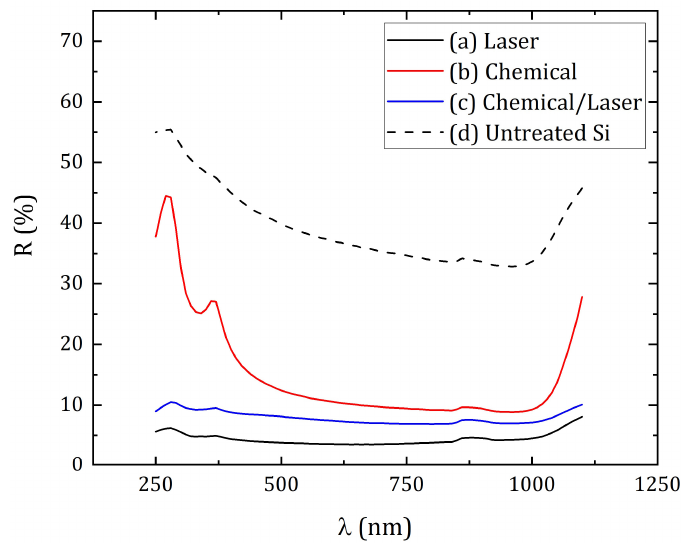
Figure 4. Total reflectance of silicon surface: ( a ) Sample #1—laser texturing of a silicon cut; ( b ) Sample #2—chemical etching; ( c ) Sample #3—hybrid chemical/laser fabrication; ( d ) Untreated Si.